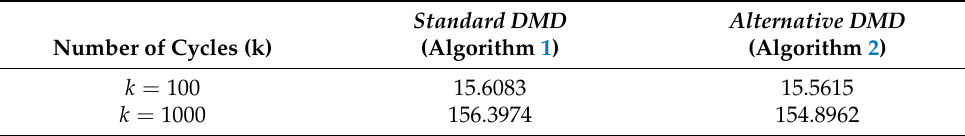
Table 6. Execution time (in sec.) by Algorithms 1 and 2.